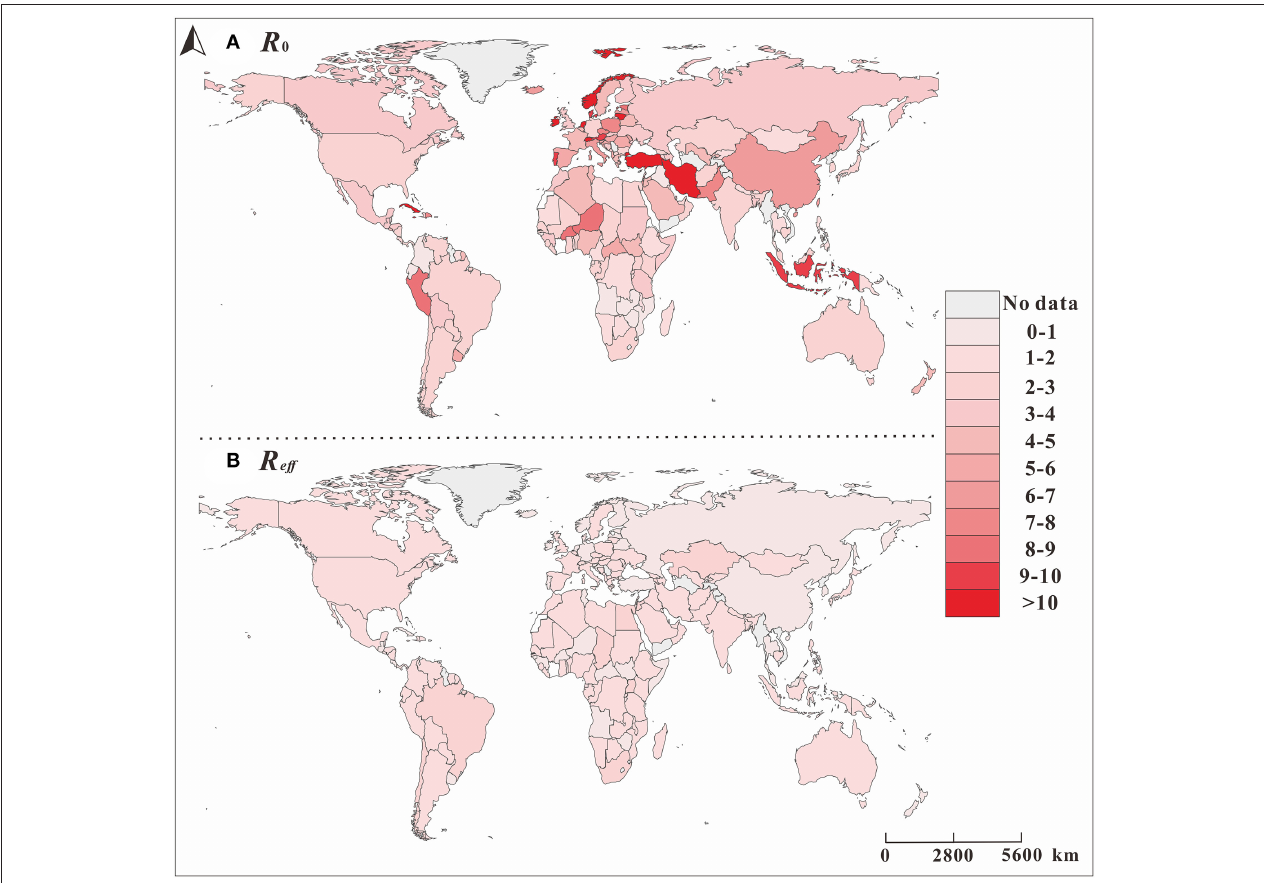
FIGURE 5 | The spatial distribution of basic reproduction number ( R 0 ) and the effective reproduction number ( R eff ) of COVID-19 in different countries. The map depicted in these figures were taken from Wikimedia Commons